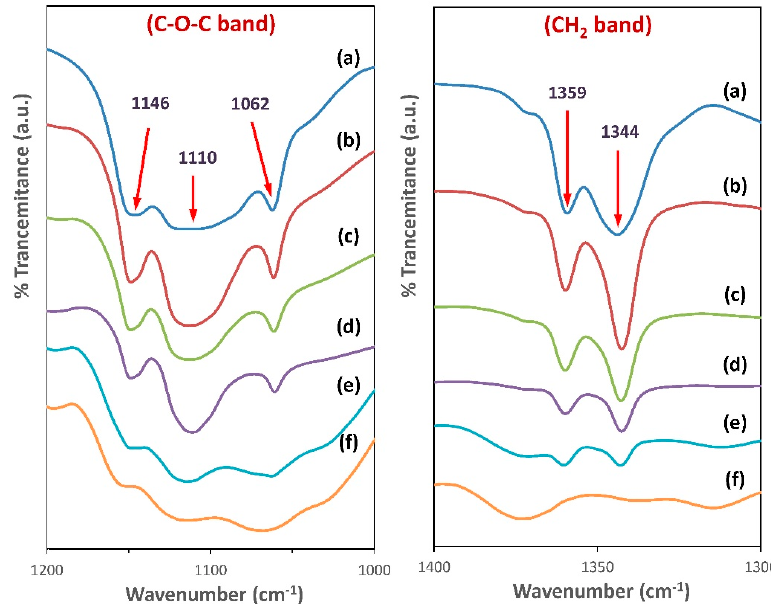
Figure 5. FTIR spectra in the regions 1000–1200 cm − 1 and 1300–1400 cm − 1 for: (a) Pure PEO; (b) PEO:MC blend weight ratio 80:20; (c) PEO:MC blend weight ratio 60:40; (d) PEO:MC blend weight ratio 40:60; (e) PEO:MC blend weight ratio 20:80; (f) Pure MC.